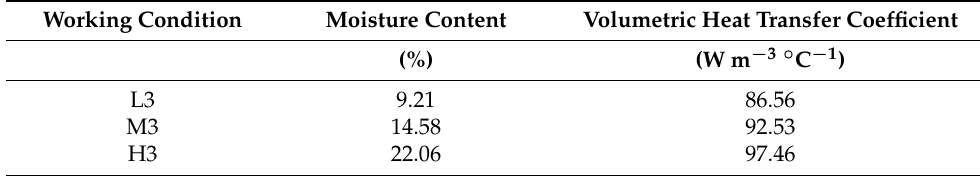
Table 5. Volumetric heat transfer coefficient for each working condition. Working